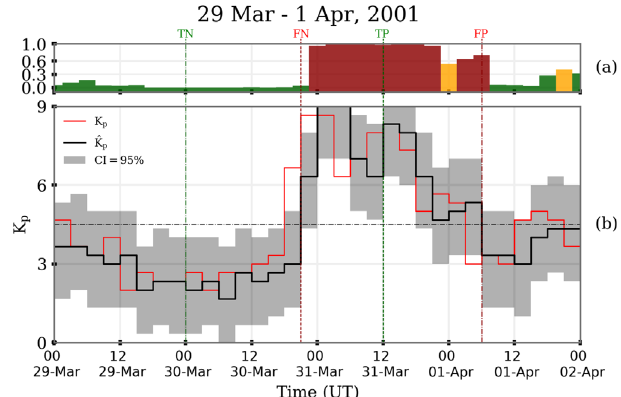
Fig. 10. Example model predictions using l OMNI model showing true positive (TP), false positive (FP), false negative (FN), and true negative (TN) predictions, mentioned by vertical lines. Top and bottom panels show the probability of geomagnetic storms and K p with uncertainty bounds (shaded)